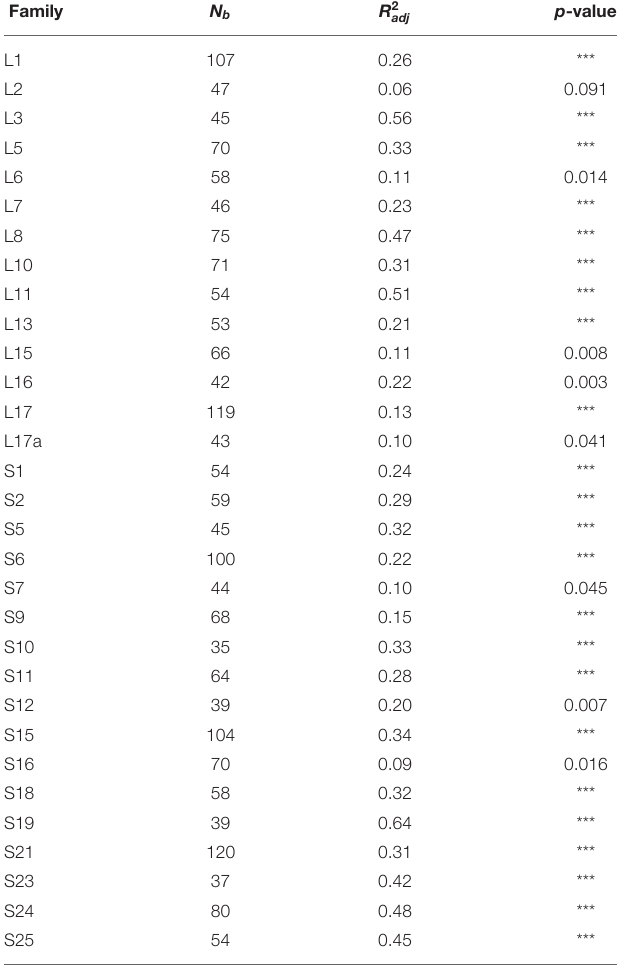
TABLE 1 | Summary of the quadratic models for each half-sib family. Family